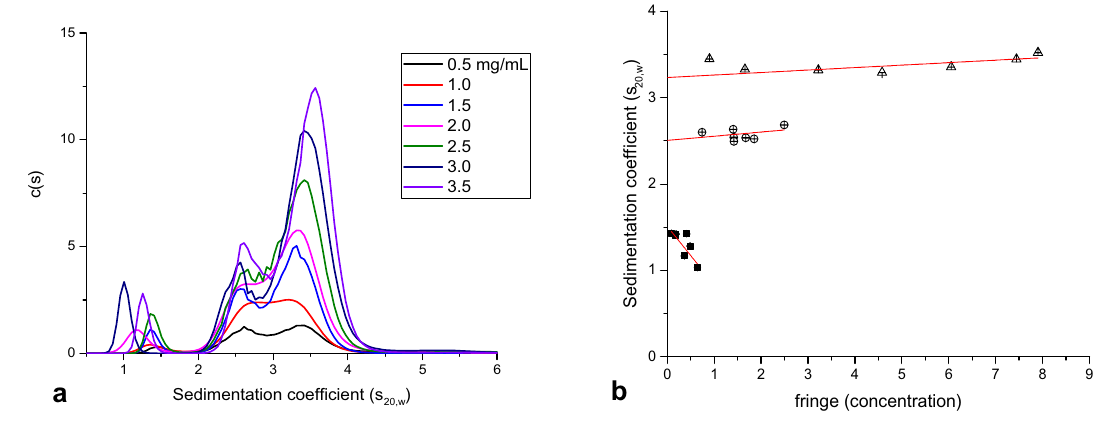
Figure 6. ( a ) Sedimentation coefficient profiles of IGlu at 7 concentrations between 0.5–3.5 mg/mL. ( b ) Integrated peaks plotted against concentration. Error bars are shown for both apparent sedimentation coefficient and concentration, however standard error was < 0.01% of values and therefore the error bars are indistinguishable from data